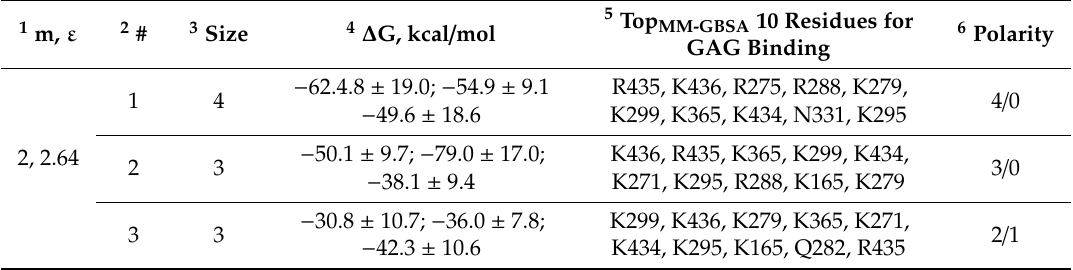
Table 5. Molecular docking MD-based analysis summary for PCPE-1 SAXS Model / HP dp6 interaction. 1 m, ε 2 # 3 Size 4 ∆ G, kcal /